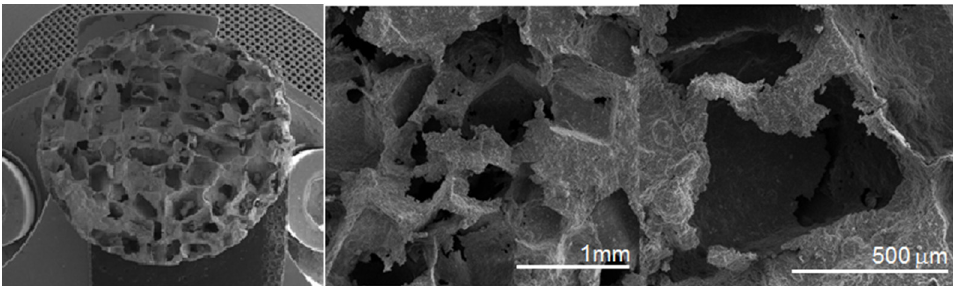
Figure 3. SEM pictures of the Ti-10 wt% 45S5 Bioglass-1 wt% Ag nanocomposite foam with porosity of 70% at different magnifications.